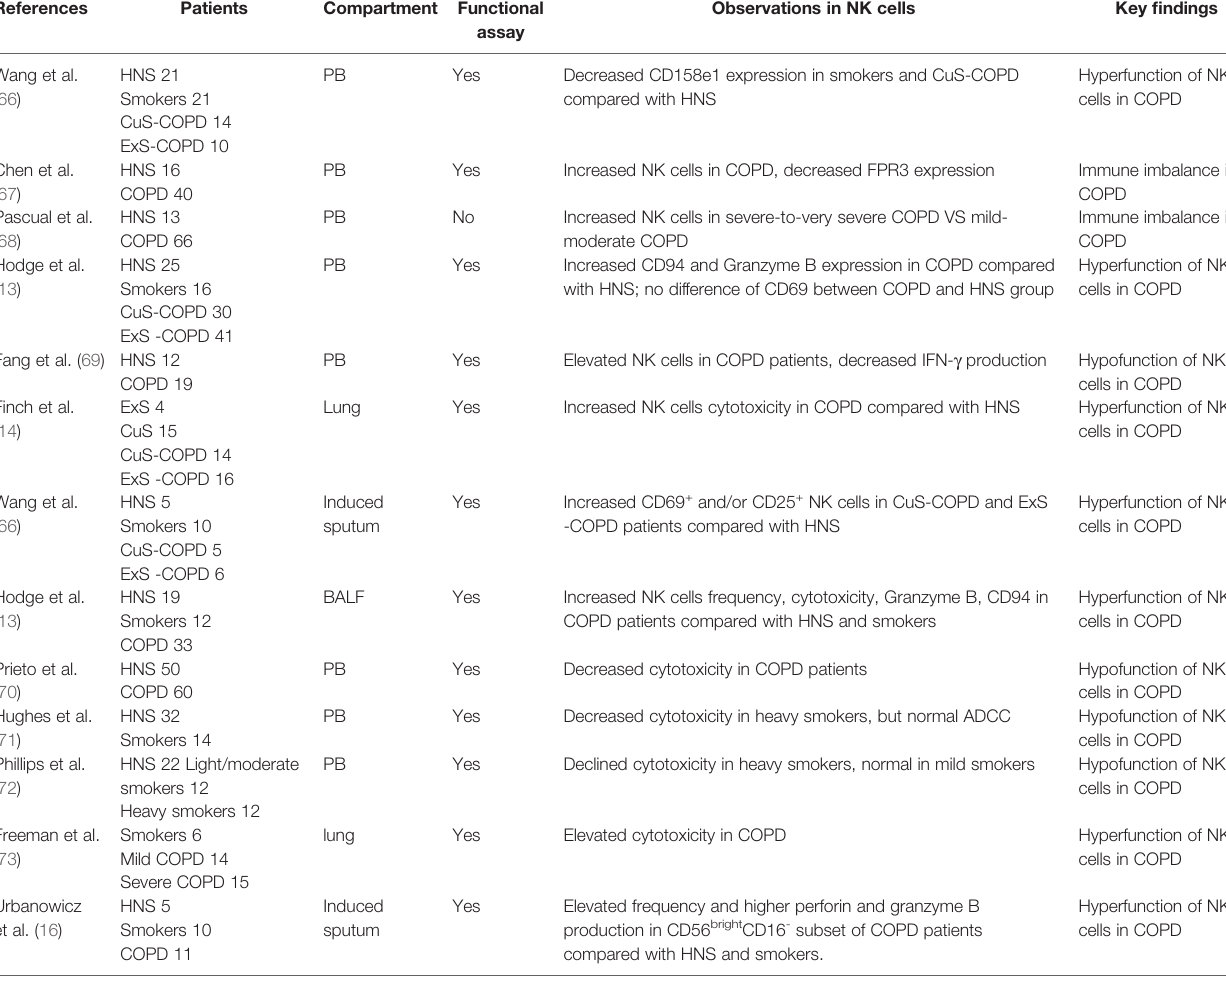
TABLE 1 | Studies of human NK cells in